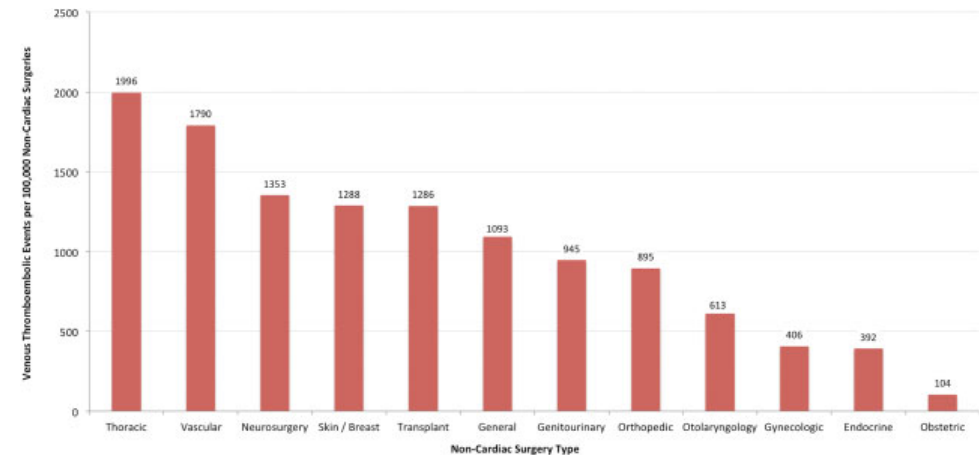
Fig. 2 Frequency of perioperative venous thromboembolism by type of major noncardiac surgery.